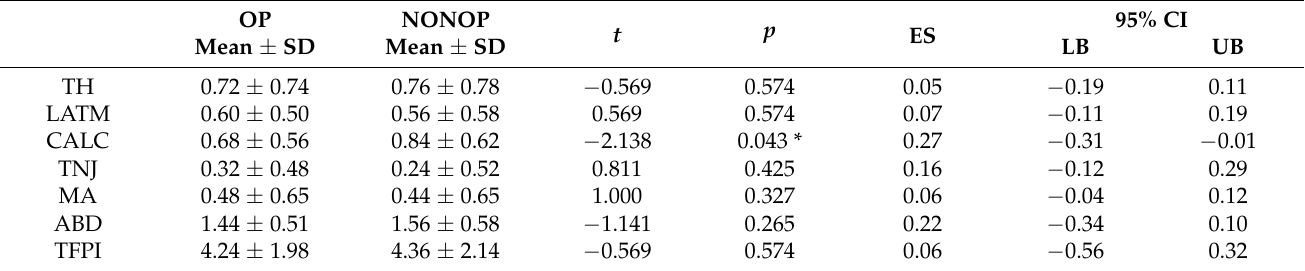
Table 3. Comparison of TFPI scores of operated and non-operated sides.